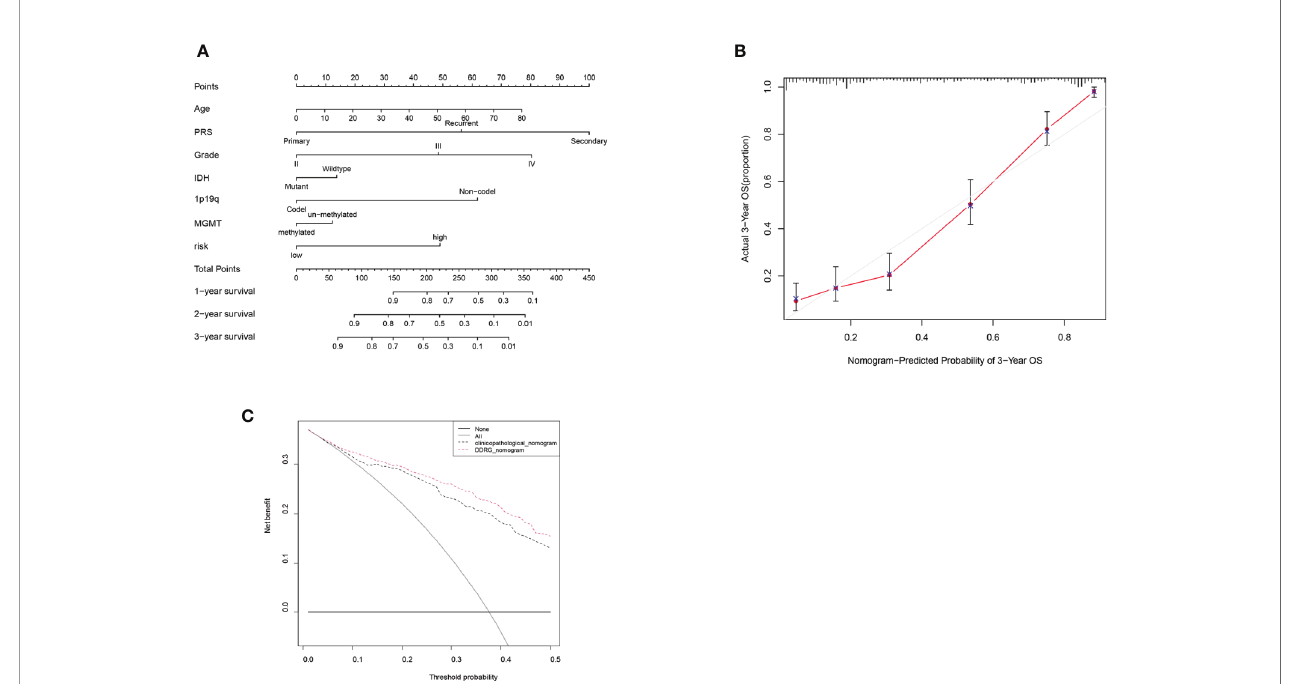
FIGURE 10 | Nomogram for the prediction of prognostic probabilities in the CGGA dataset. (A) The nomogram for the prediction of OS was developed using the CGGA dataset. (B) The calibration plots for predicting 3-year survival. (C) Decision curve analysis for the DDRGs signature nomogram and the clinicopathological nomogram to estimate the OS. CGGA, Chinese Glioma Genome Atlas; OS, overall survival; DDRGs, DNA damage repair